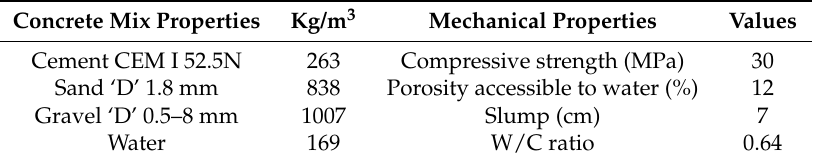
Table 5. Compositions and mechanical properties of the R30A7 ordinary